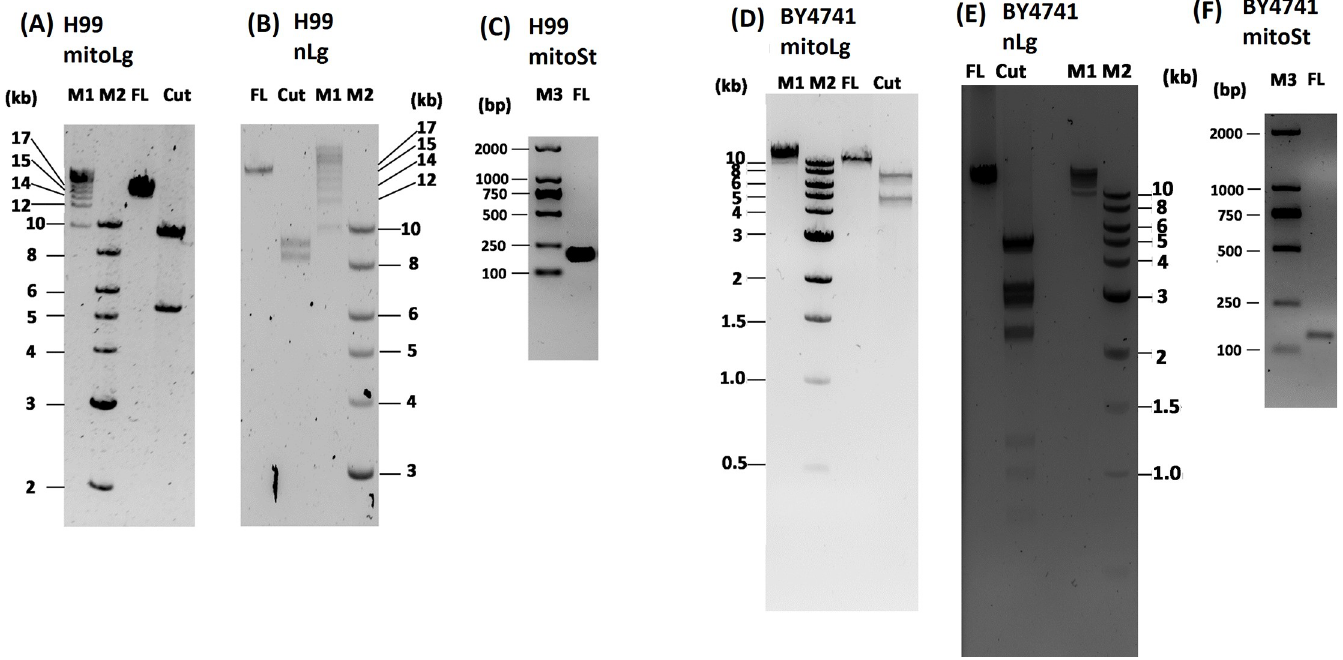
Fig 1. Amplification of long mtDNA and nDNA and short mtDNA from C . neoformans H99 and S . cerevisiae BY4741 DNA extract. (A and D) mitoLg, long mitochondrial DNA fragments from H99 and BY4741, (B and E) nLg, long nuclear DNA fragments from H99 and BY4741, (C and F) mitoSt, short mitochondrial DNA fragments from H99 and BY4741. M1, M2 and M3 are different size DNA ladders. FL, full length; Cut, restriction enzyme digested full length